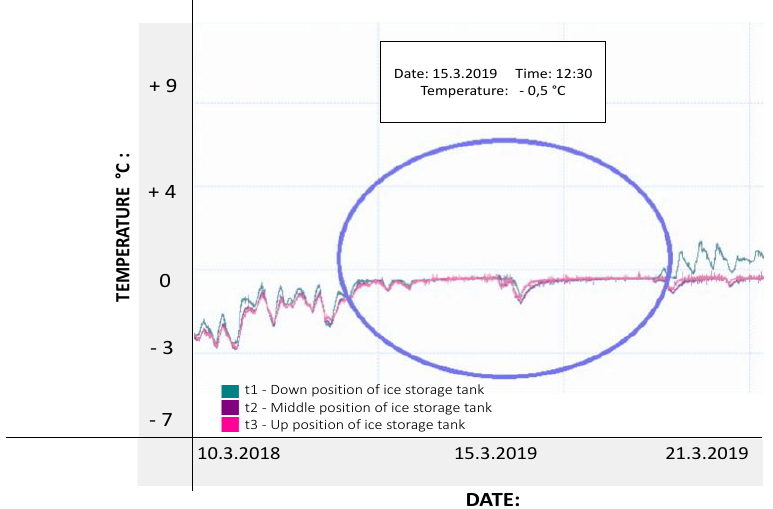
Figure 20. III. Phase—Melting process.